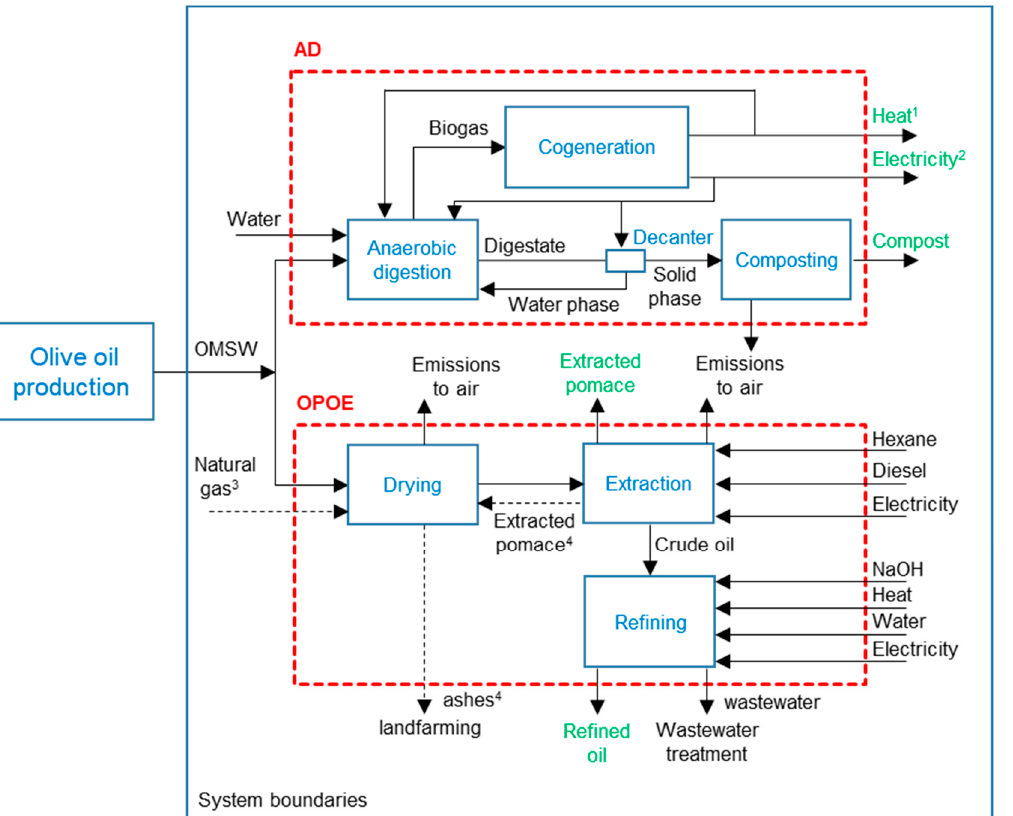
Figure 1. System boundaries.